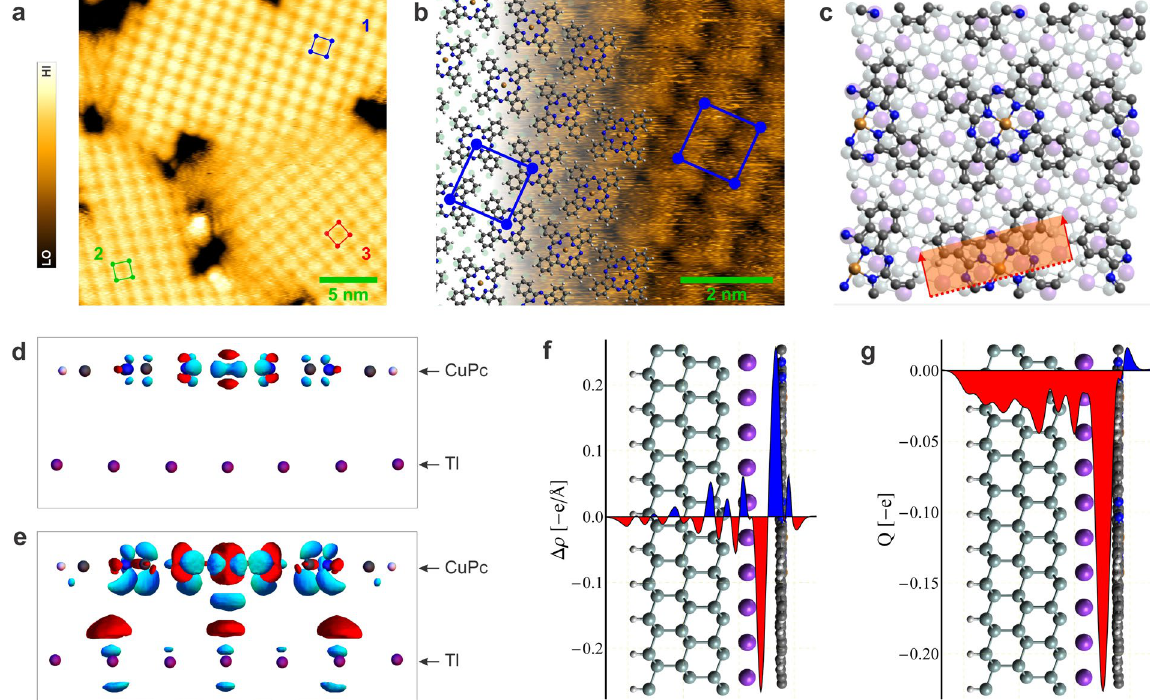
Figure 2. Self-assembly of CuPc molecules on the thallium-passivated Si(111) surface. ( a ) The Tl-passivated surface covered by almost 1 ML of CuPc molecules. Three domain orientations of the ordered CuPc array are shown. U s = − 3 V. ( b ) STM image of the CuPc array superimposed by the structural model. U s = − 2 V. Red, green and blue squares mark unit cells of the CuPc molecular arrays. ( c ) Top view of the relaxed structural model. Purple and gray spheres denote positions of Tl and Si atoms, respectively. ( d , e ) Isosurfaces of the constant difference of the charge density. The cross-section plane, the direction of the view and the volume imaged is marked in the panel c. The isovalues are set to 0.012 eÅ − 3 (panel d) and 0.005 eÅ − 3 (panel e). Red and blue colors represent electron density depletion and accumulation, respectively. ( f , g ) Side view of the relaxed structure superimposed by the plane-integrated charge transfer Δ ρ (panel f) and the cumulative charge transfer Q (panel